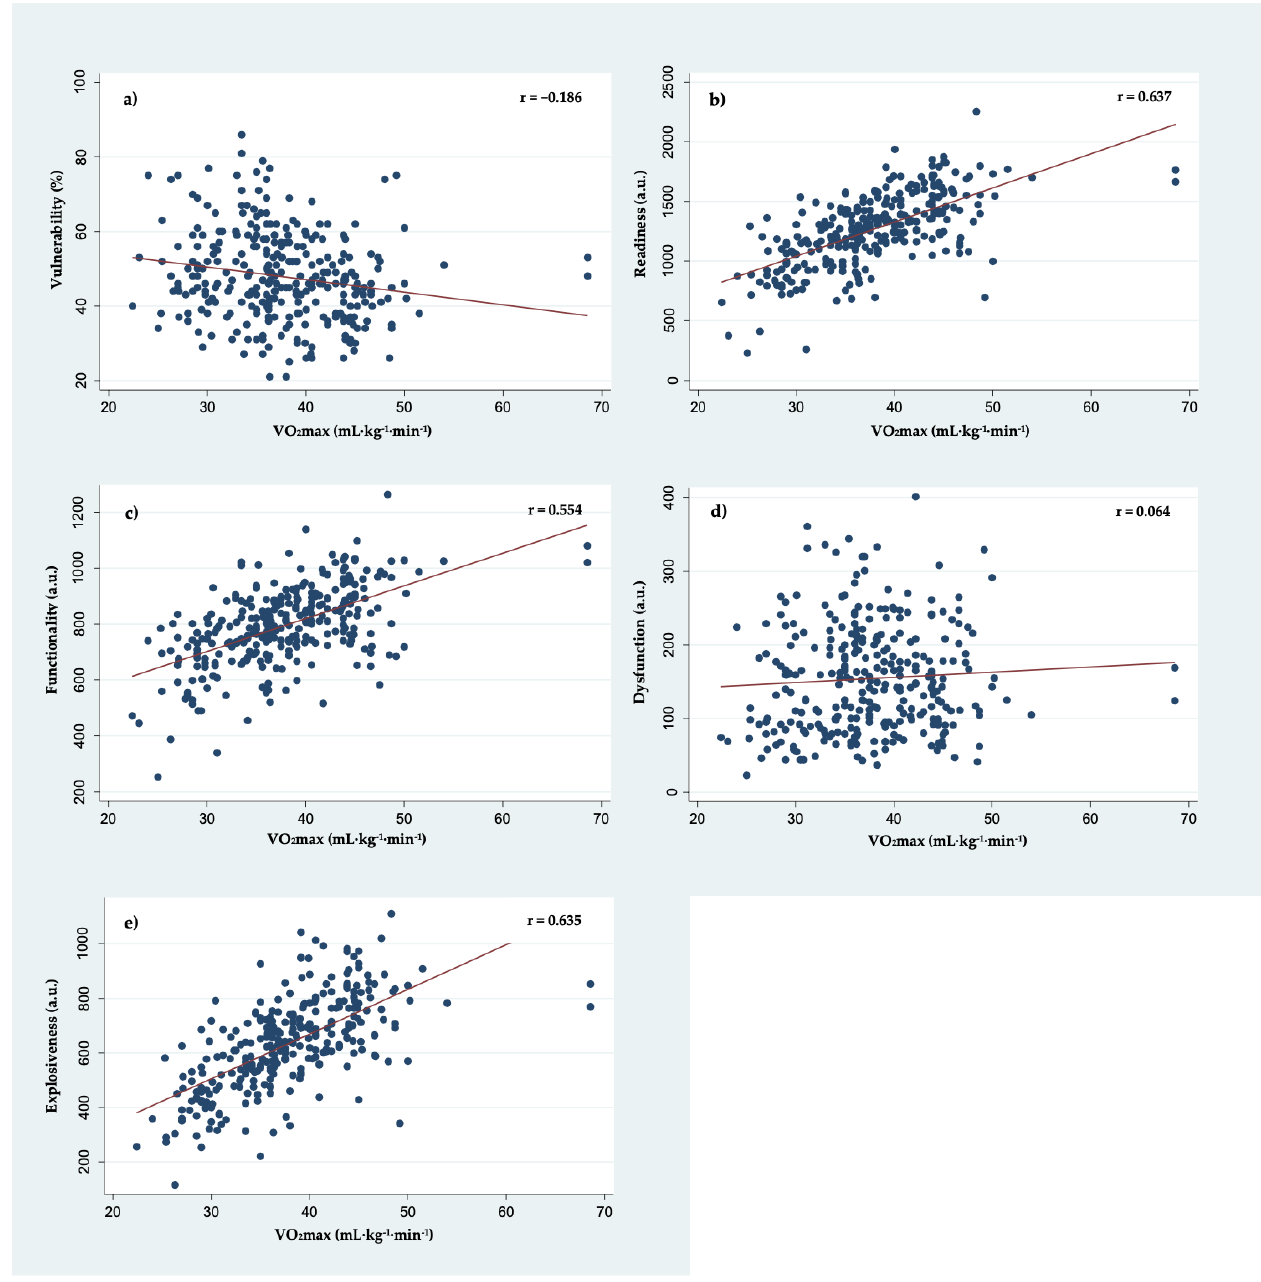
Figure 2. Correlation plots of VO 2 max with ( a ) vulnerability, ( b ) readiness, ( c ) functionality, ( d ) dysfunction, and ( e ) explosiveness scores derived from a 3D-MCS during functional movement screening